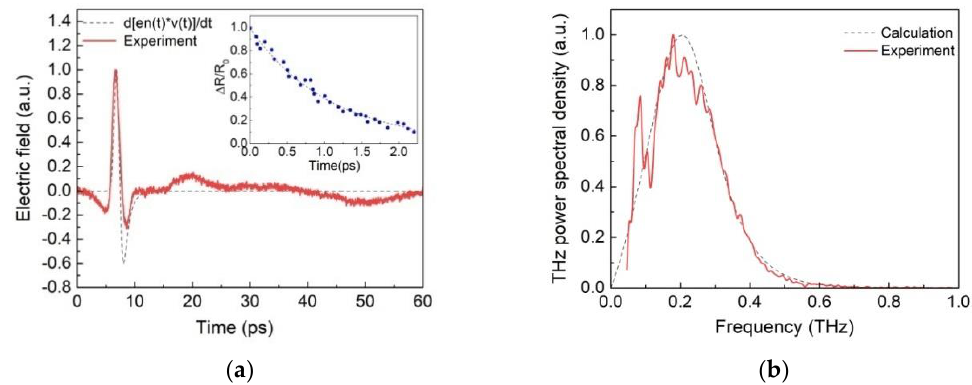
Figure 5. Waveform ( a ) and spectrum ( b ) of THz pulse from PCA. Inset: results of the pump-probe experiment.